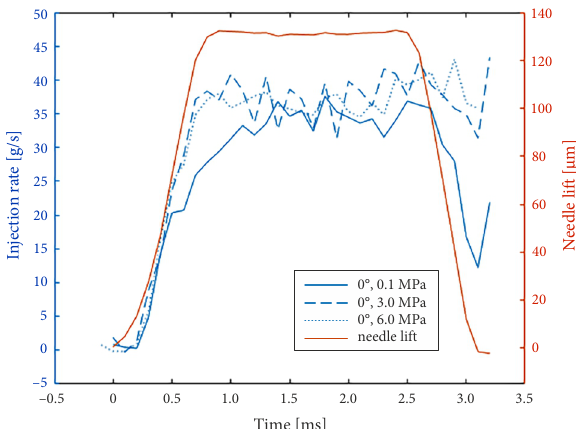
Figure 5. Measured injection rates and needle lift for 1500 min –1 , 300 N ⋅ m, 0° plug valve state, with different